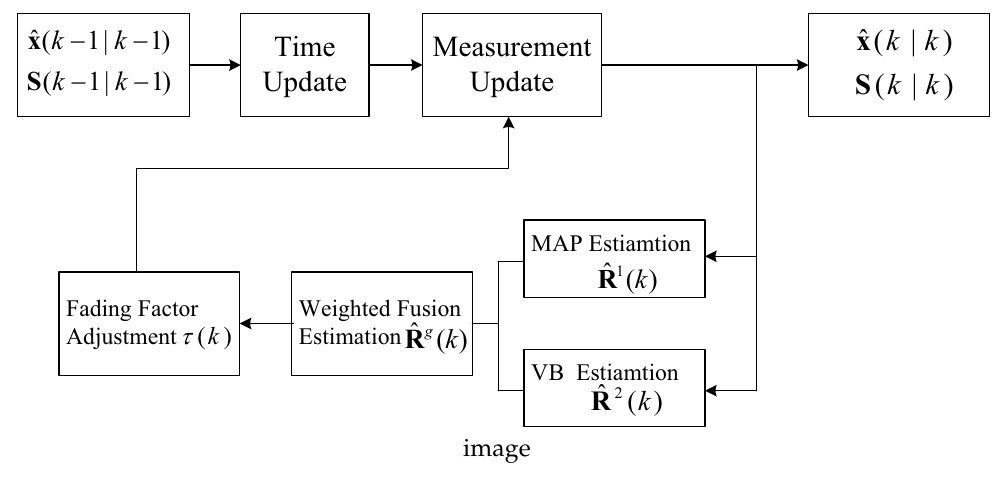
Figure 1. Principle block diagram of the HASCKF